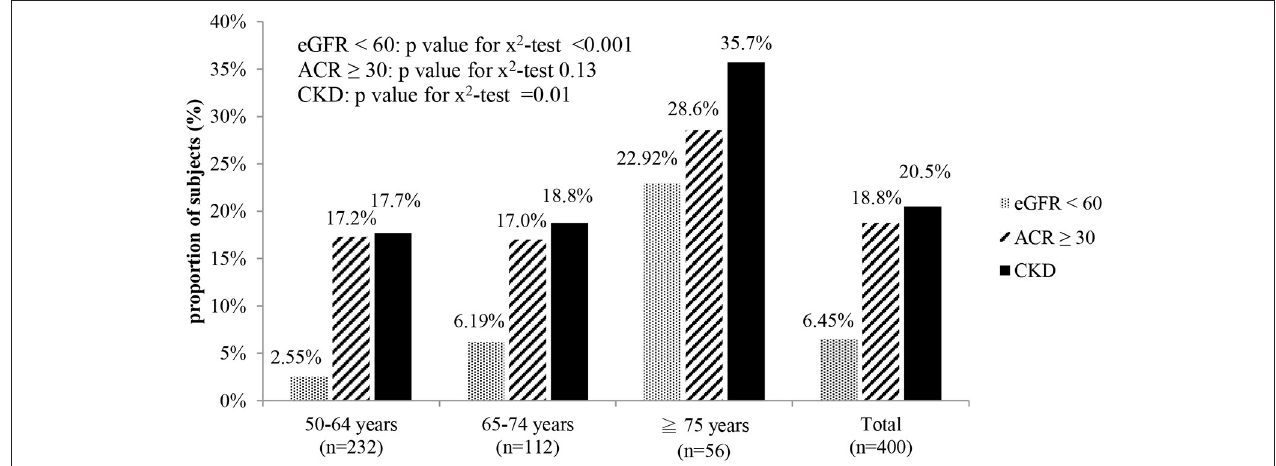
FIGURE 1 | Proportion of subjects with CKD in different age groups. eGFR < 60: estimated glomerular filtration rate < 60 mL/min/1.73 m 2 . ACR ≥ 30: urine albumin creatinine ratio ≥ 30 mg/g. CKD: eGFR < 60 or ACR ≥